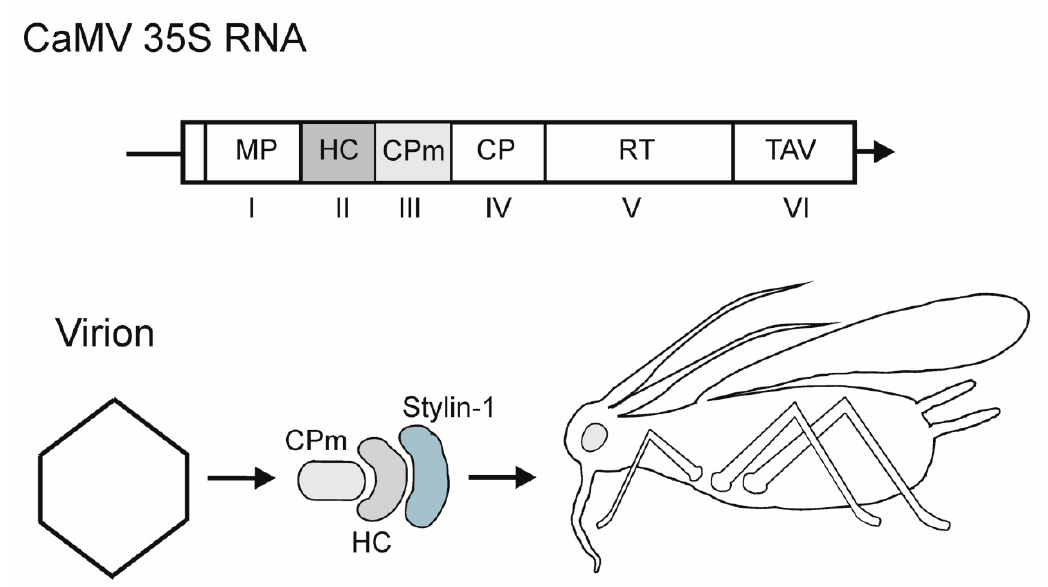
Figure 1. Top, scheme of the 35S mRNA of cauliflower mosaic virus (CaMV). Genes are indicated by Roman numerals. Encoded proteins and protein domains: MP, cell-to-cell movement protein (p1); HC, helper component (p2); CPm, minor capsid protein (p3); CP, major capsid protein; RT, reverse transcriptase; TAV, transactivator/viroplasmine. Arrow indicates the 3 ′ -end of RNA. The genes involved in transmission are shaded. Bottom, scheme of protein interactions in CaMV aphid transmission. Stylin-1, putative receptor in the aphid’s stylet.